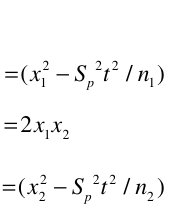
Table 4: Estimation of CZP in pharmaceutical tablets (Multi-relax ® tablets) by the proposed spectroscopic methods Method